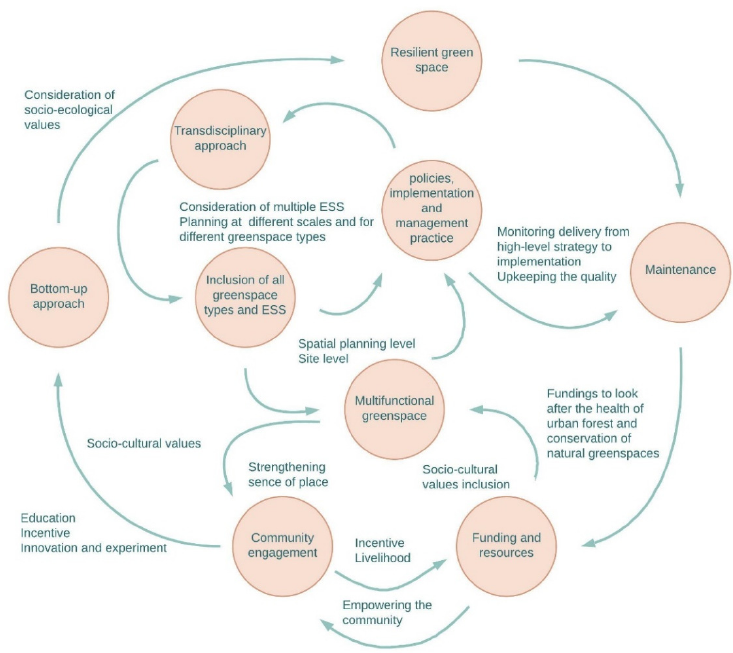
Figure 8. Systems mapping diagram illustrates the identified trade-offs to increase landscape resil- iency and sustainability. Source: